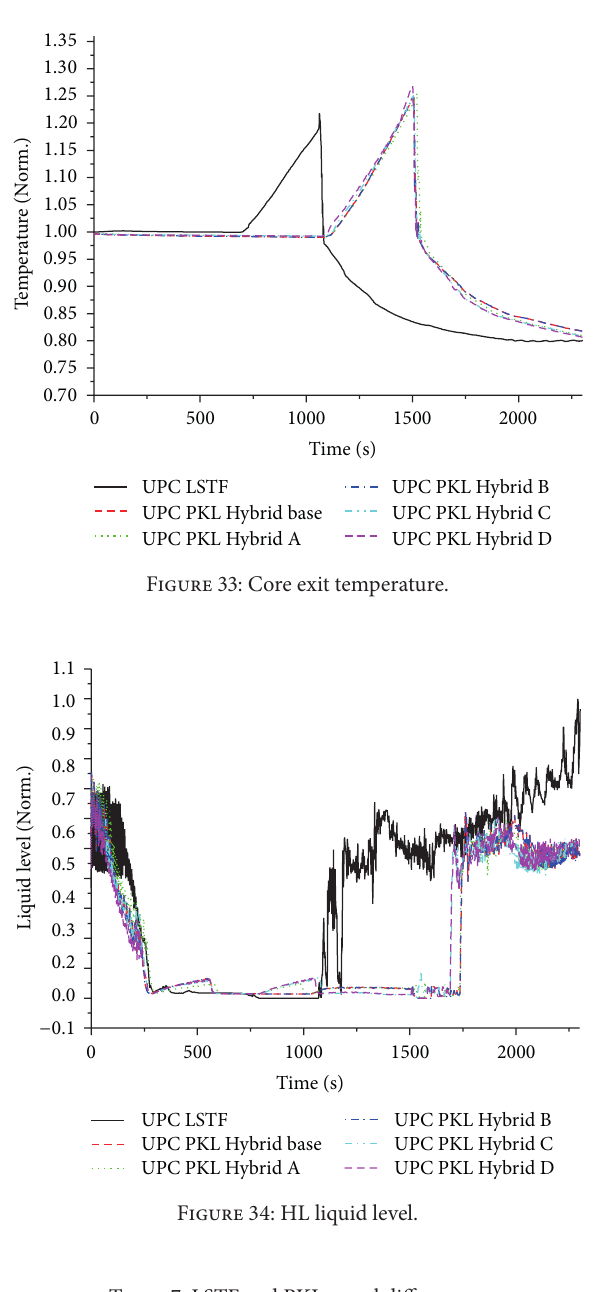
Table 7: LSTF and PKL vessel differences.